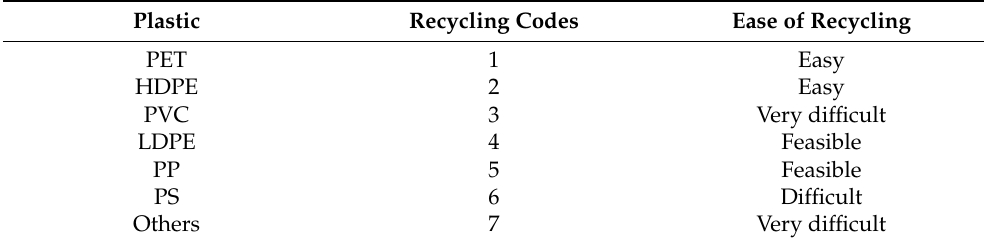
Table 12. Ease of recycling the most-used plastics globally